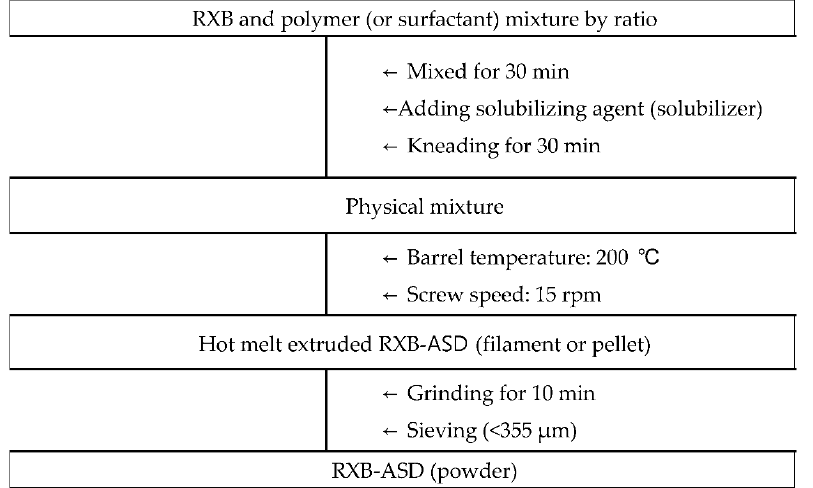
Figure 1. Preparation process of hot-melt extruded RXB-ASD. Table 1. Formulation of hot-melt extruded RXB-ASDs using various polymer mixtures.